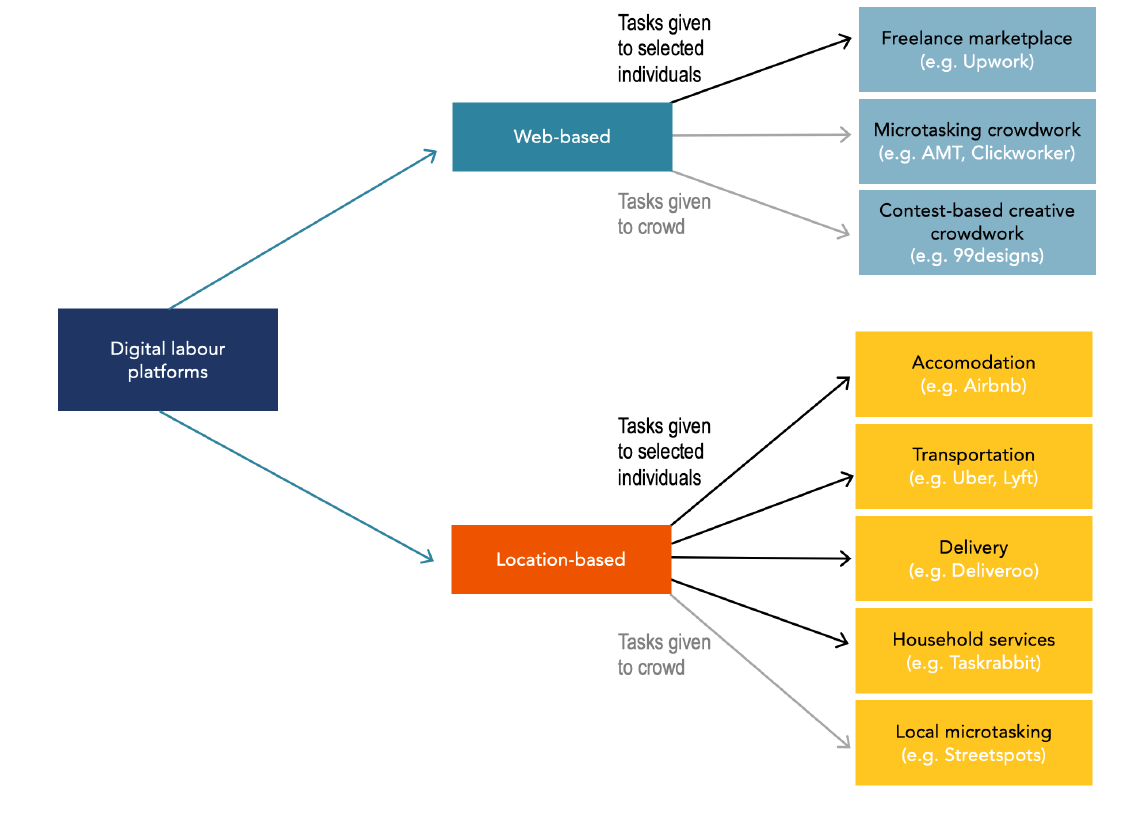
Figure 2. Digital Labor Platforms: a classification (source: adapted from